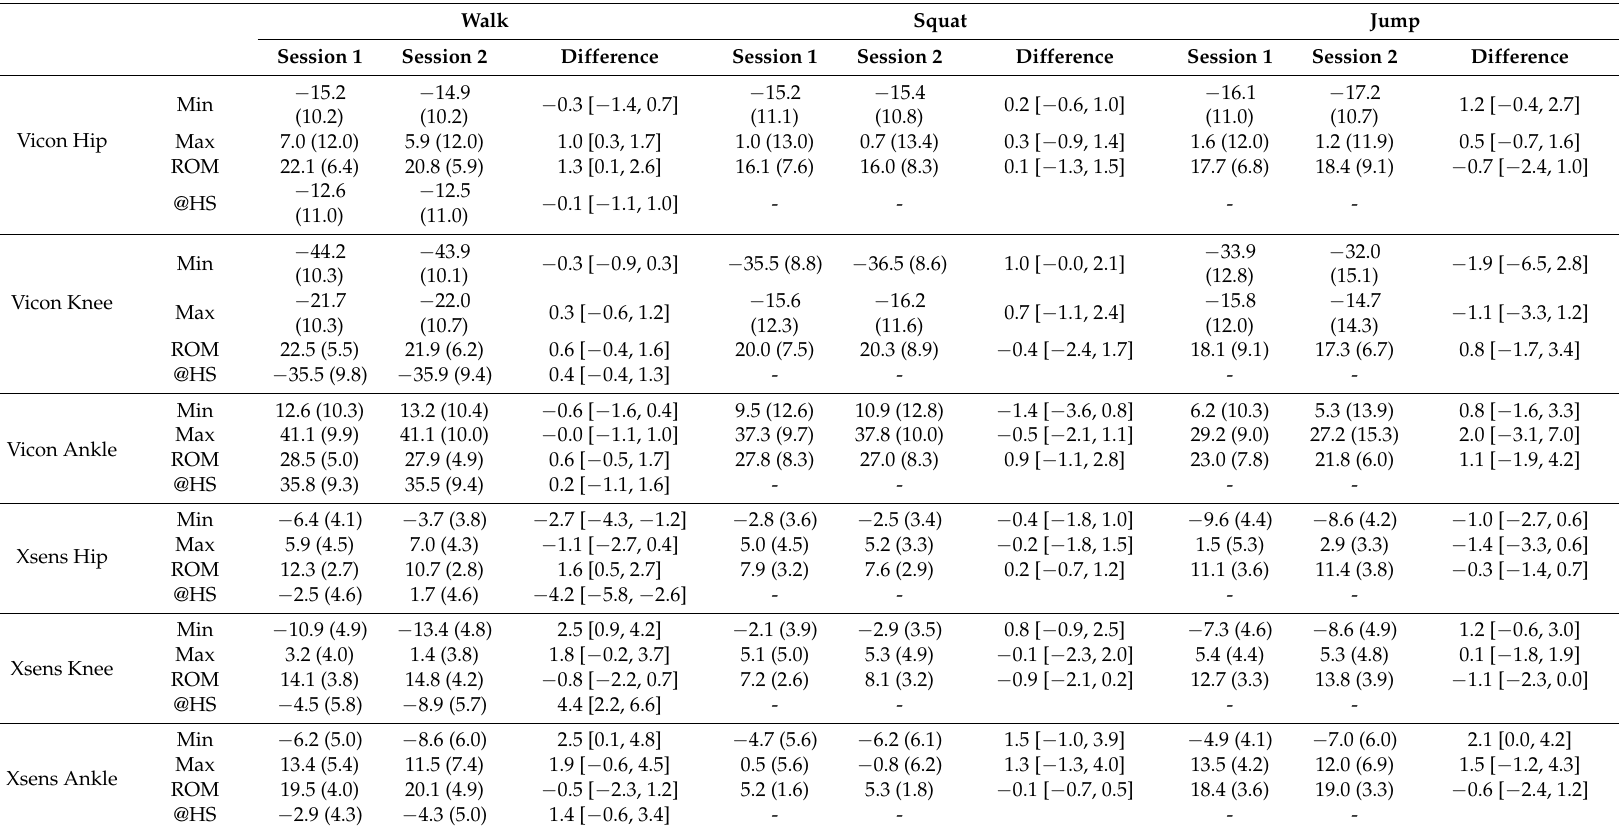
Data for each session are mean (standard deviation). Data for the difference are difference [95% confidence